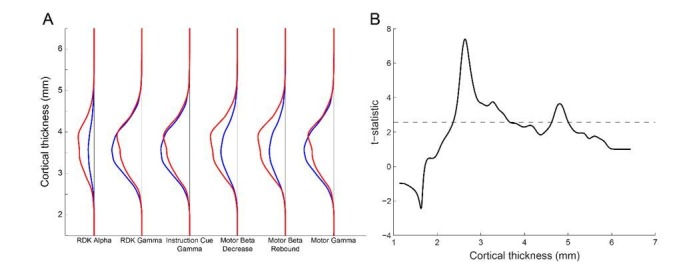
Laminar specificity across the range of cortical thickness.(A) The y-axis represents the distance between the pial and white matter vertices (cortical thickness). For each visual and sensorimotor frequency band and task epoch (x axis), the probability density function for pial (blue line) and white matter (red line) classifications is shown over the range of cortical thickness. There is a bias toward the white matter surface where the cortex is thick (~4mm and thicker), and toward the pial surface here the cortex is thinner (~3.5mm). However, the overall pial/white matter bias is driven by the frequency band. (B) The y-axis represents the t-statistic from a one-way t-test of the difference in the probability density of cortical classification across each frequency band and task epoch (pial-white for gamma, and white-pial for alpha and beta). The ability to discriminate between laminae drops off when the cortical thickness is below 2.5mm.